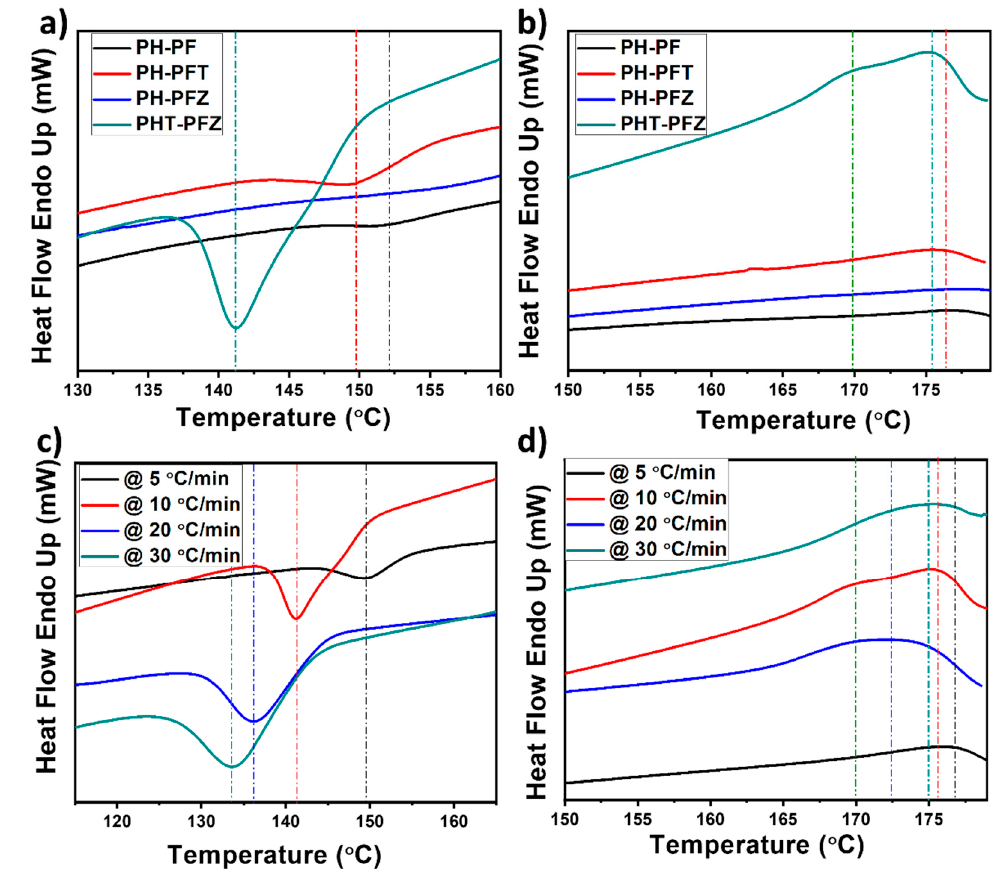
Figure 5. Differential scanning calorimeter (DSC) curves for the coaxial electrospun fibers ( a ) endothermic and ( b ) exothermic heat flow curves for the nanocomposites ( c , d ) heat flow behavior of the hybrid PHT-PFZ composite at different heating/cooling rates.